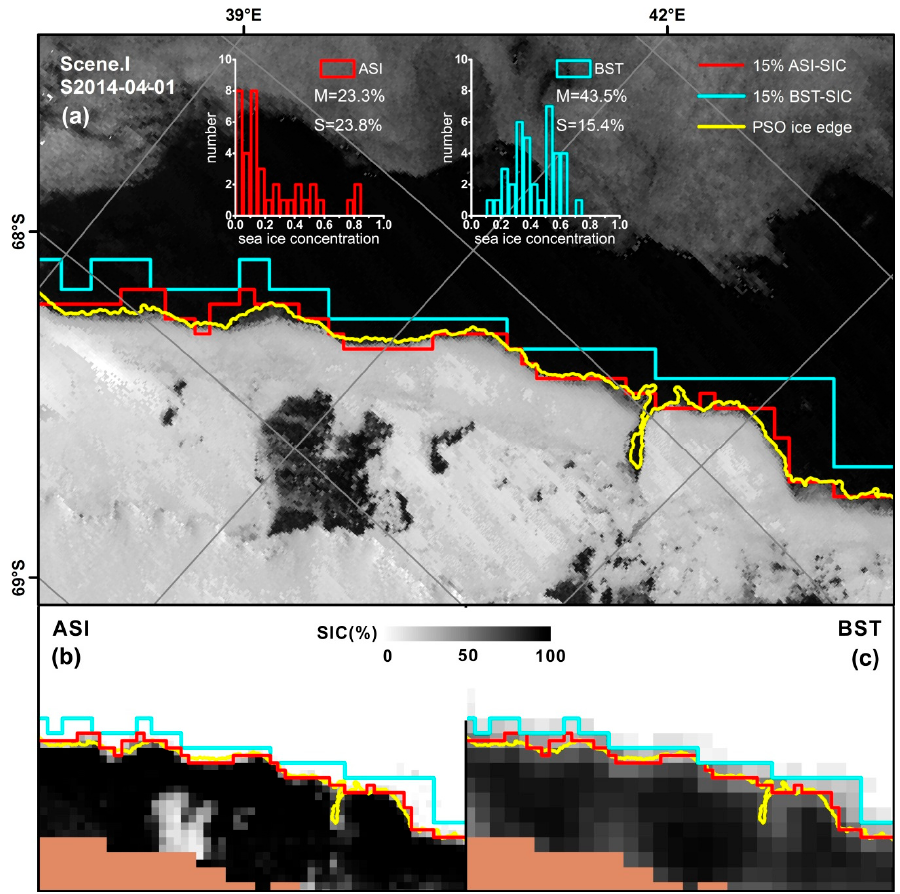
Figure 5. Contour of the 15% ASI ‐ SIC, 15% BST ‐ SIC and the PSO ice edge overlaid on (a) MOD09GA, (b) ASI ‐ SIC, (c) BST ‐ SIC, for the Antarctic at 1 April 2014. Remote Sens. 2018 , 10 , 317